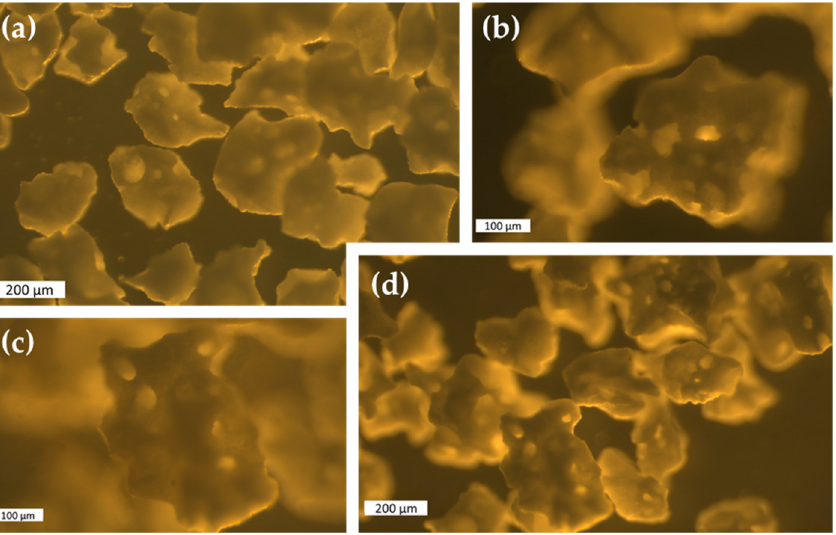
Figure 1. Stereomicroscopic images of 150–250 µm ( a , b ) and 150–500 µm ( c , d ) BCP granules. Scale bars: 200 µm ( a , d ), 100 µm ( b , c ).